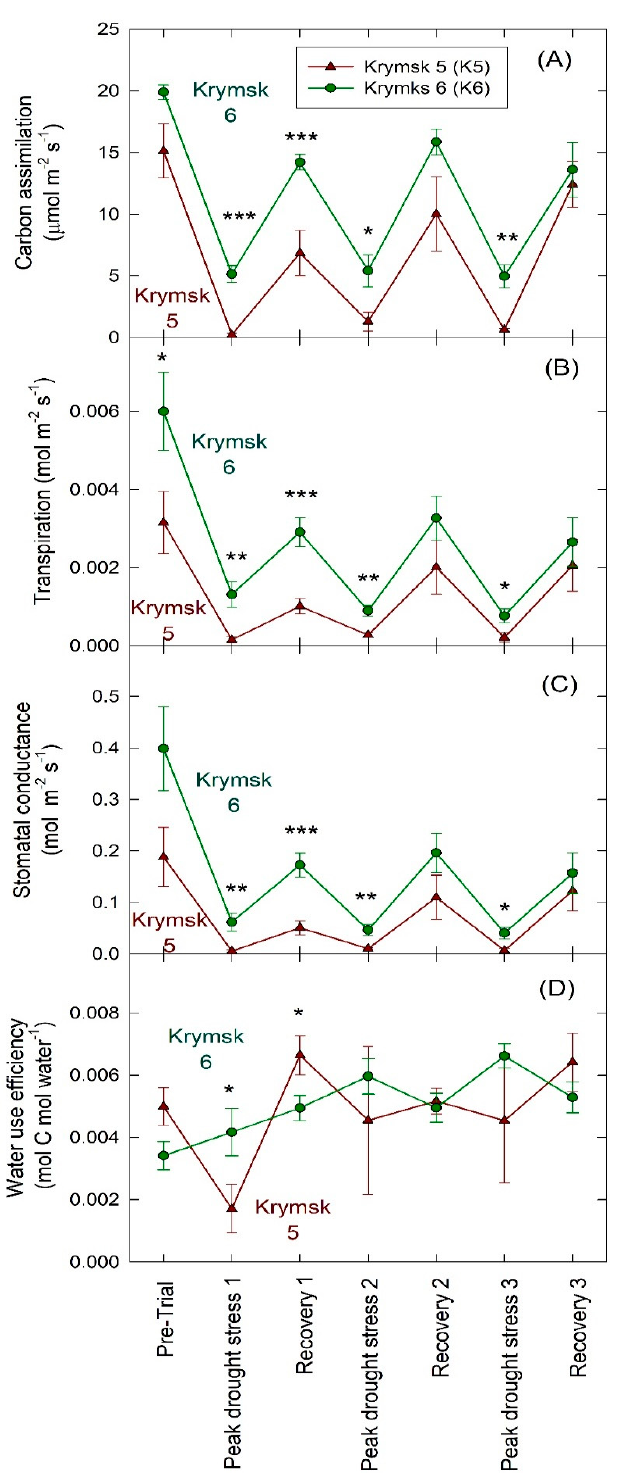
Figure 5. Leaf level gas exchange parameters: ( A ) carbon assimilation, ( B) transpiration, ( C) stomatal conductance (g s ), and ( D ) water use efficiency (WUE) for rootstocks Krymsk ® 5 ( red triangles ) and 6 ( green circles ) during Trial 2. Three trees per treatment were measured with three leaves sampled per tree. Gas exchange chamber was allowed to come to equilibrium for 10 min before collecting gas exchange parameters for 20 min. Trees were sampled before drought imposition, the day of peak drought stress, and two days after irrigation when recovery transpiration rates peaked through three dry-down periods. *** p < 0.001; ** p < 0.01; * p <